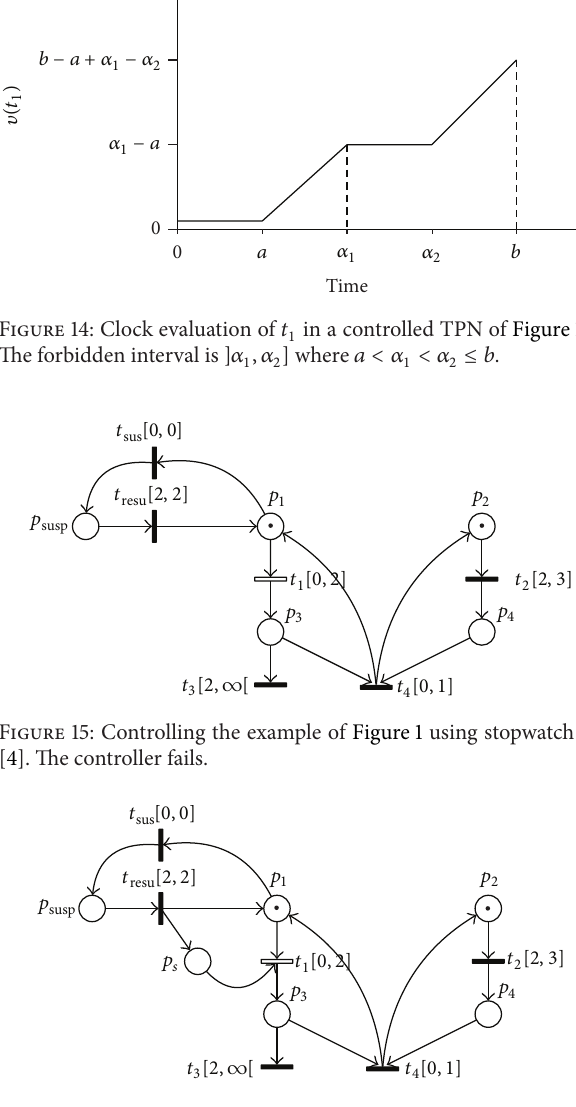
Figure 16: Controlled model of Figure 1 using stopwatch of